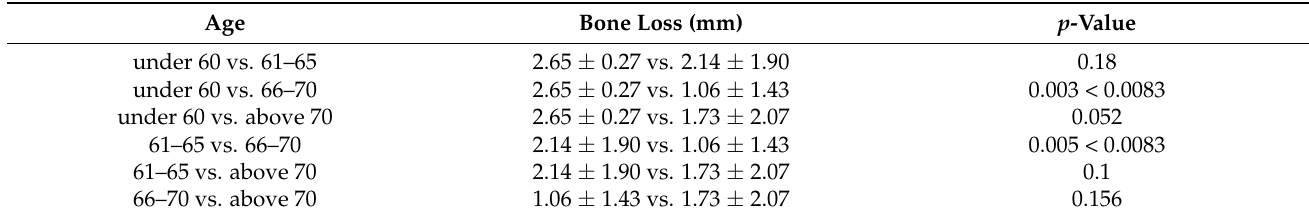
Table 6. MBL of implants in IC-RPDs and IODs based on multiple variables.